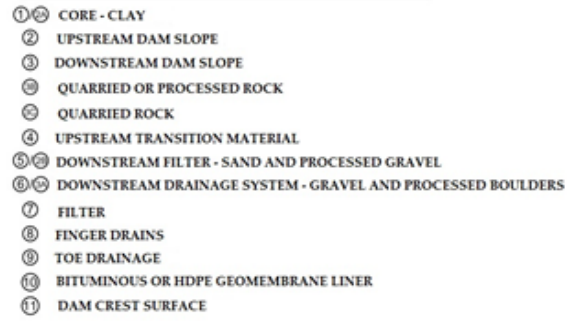
Figure 10. Examples of a geomembrane liner, cutoff trench, and grout curtain system in a TSF.